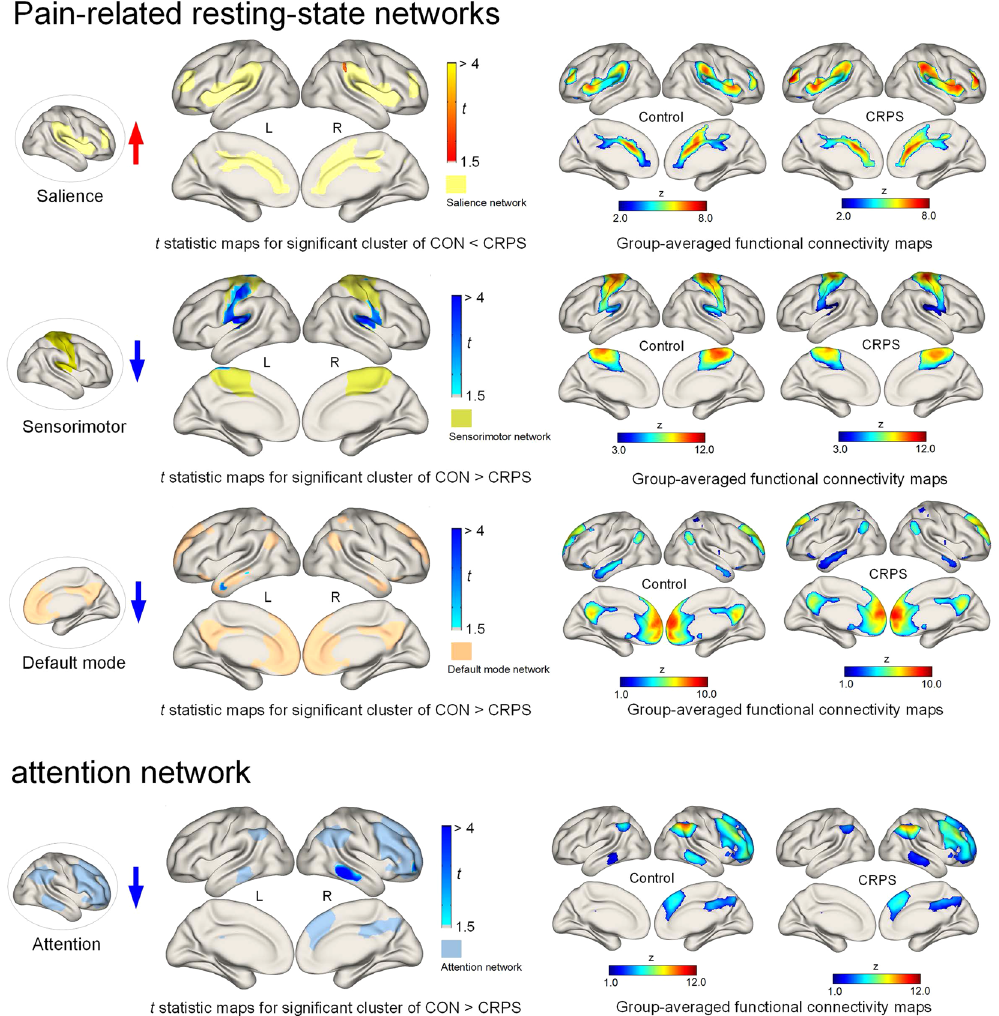
Figure 1. Statistical parametric map of the t -statistic images of significant clusters indicating the group differences in functional connectivity and group-averaged functional connectivity maps for each group (control vs. CRPS). For clusters in the attention network, there were reduced functional connectivity in individuals with CRPS relative to the control group. For the pain-related RSNs, individuals with CRPS showed enhanced functional connectivity in the salience network as compared with the control group. In contrast, reduced functional connectivity was observed in the clusters of the sensorimotor and default mode networks in the CRPS group, as compared with the control group. BrainNet Viewer 50 was used to visualize three-dimensional rendering of the clusters and the RSNs in the MNI space. CON, control; CRPS, complex regional pain syndrome; RSN, resting state network; MNI, Montreal Neurological